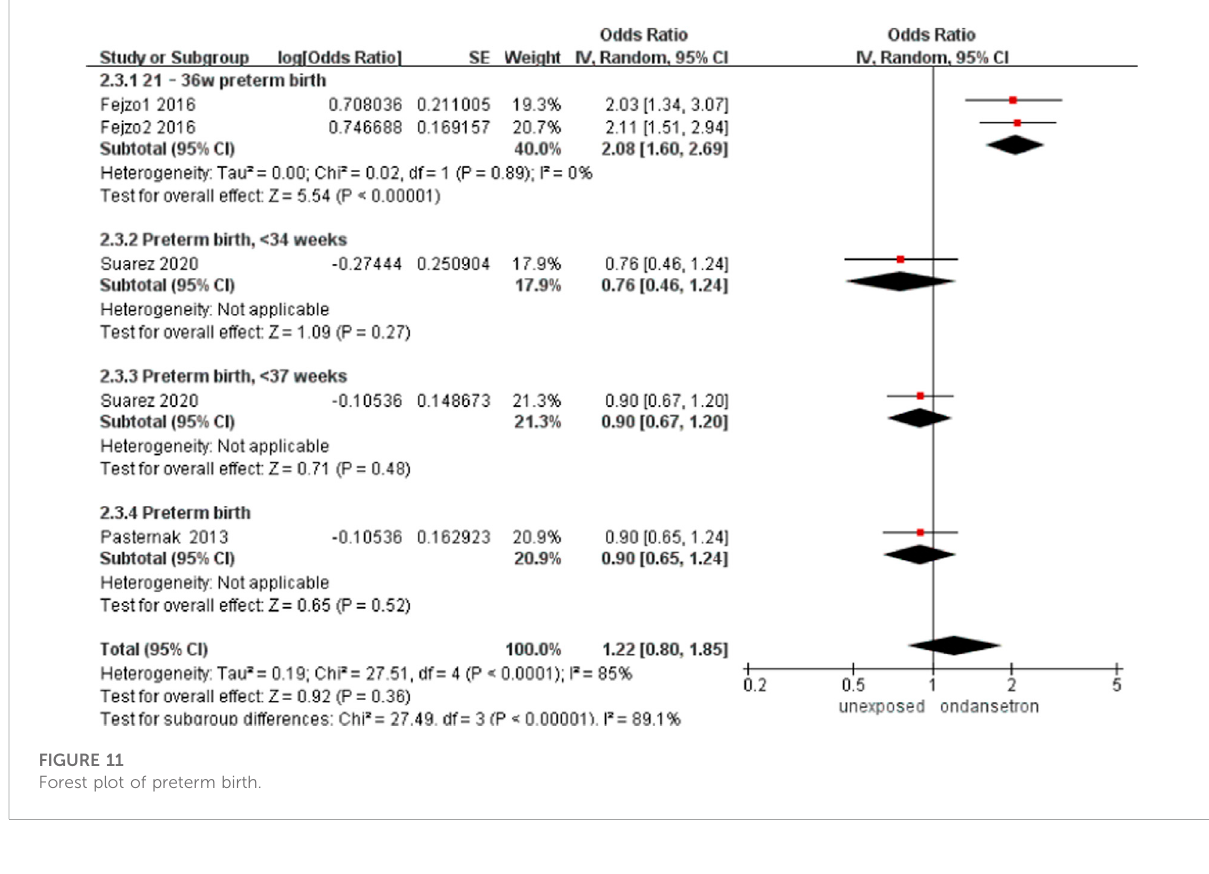
FIGURE 11 Forest plot of preterm birth.